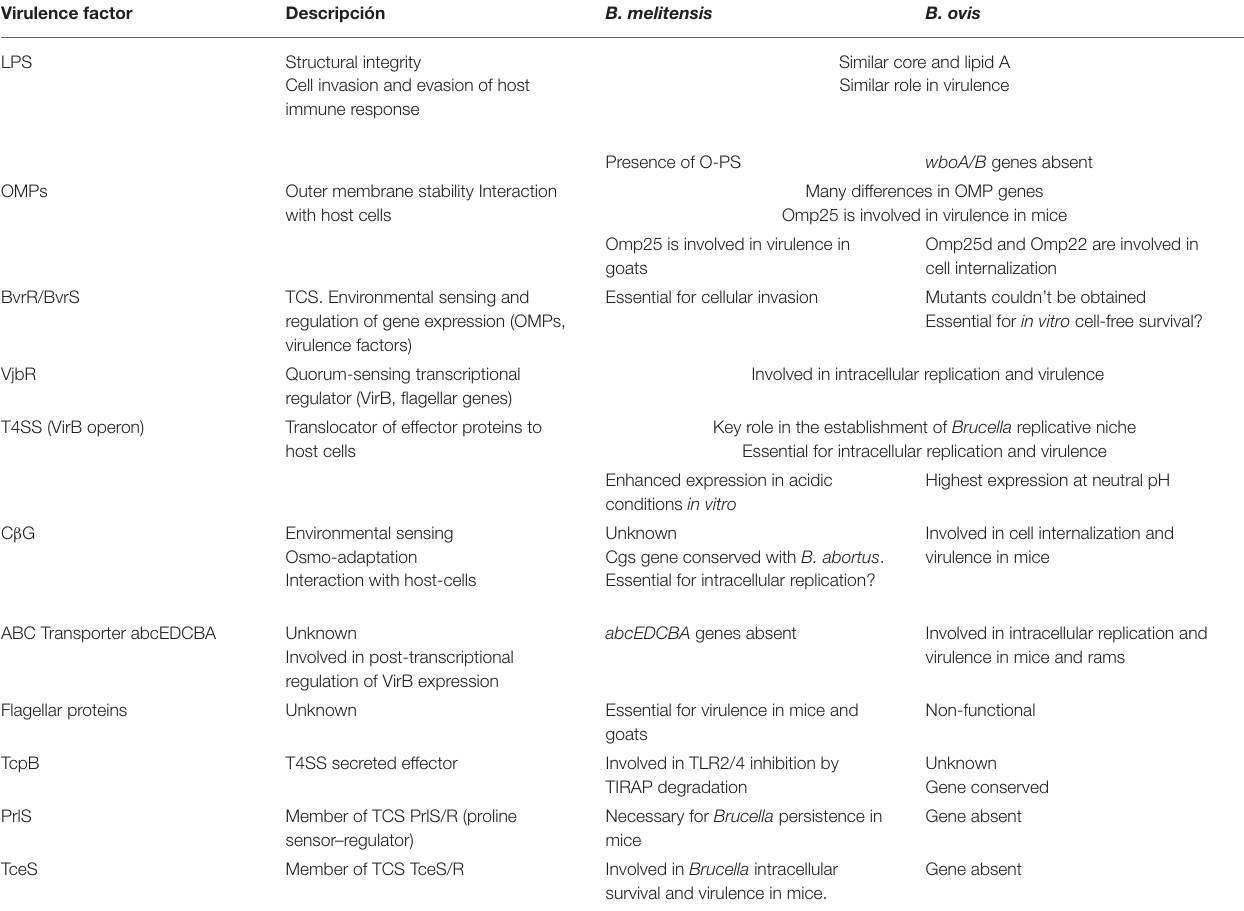
TABLE 3 | Comparison of virulence factors in B. melitensis and B. ovis .